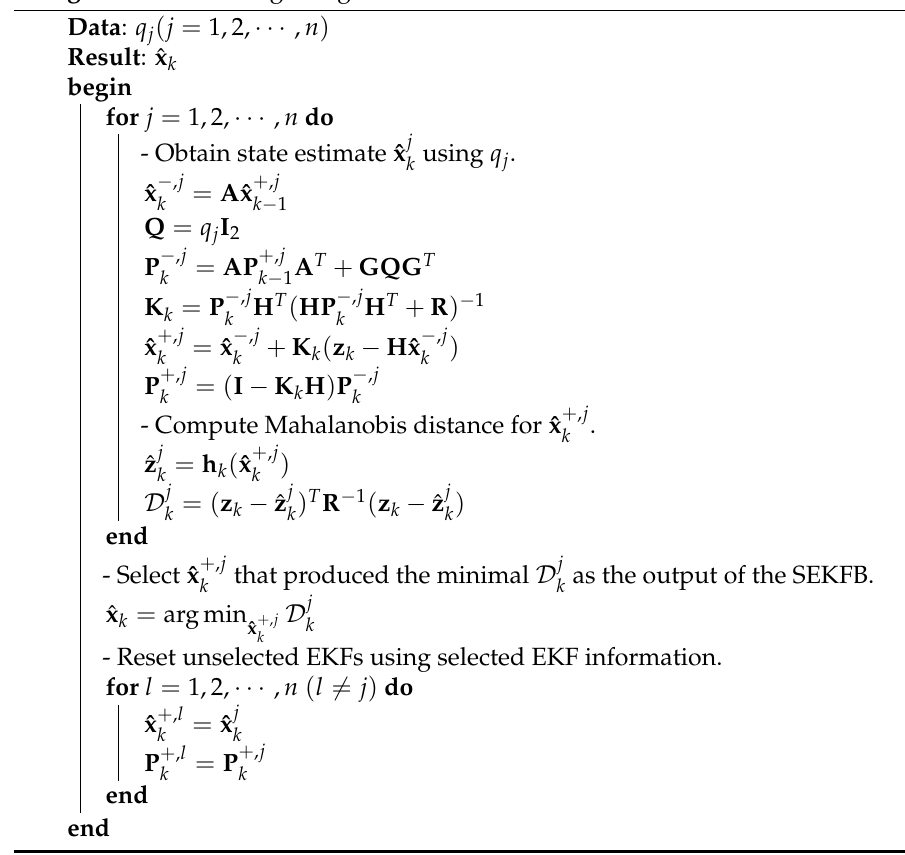
Algorithm 1: Filtering using